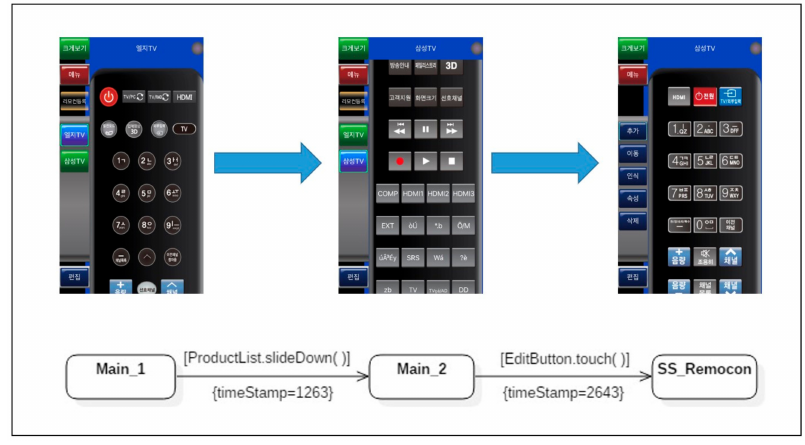
Figure 8. An expected activity model of